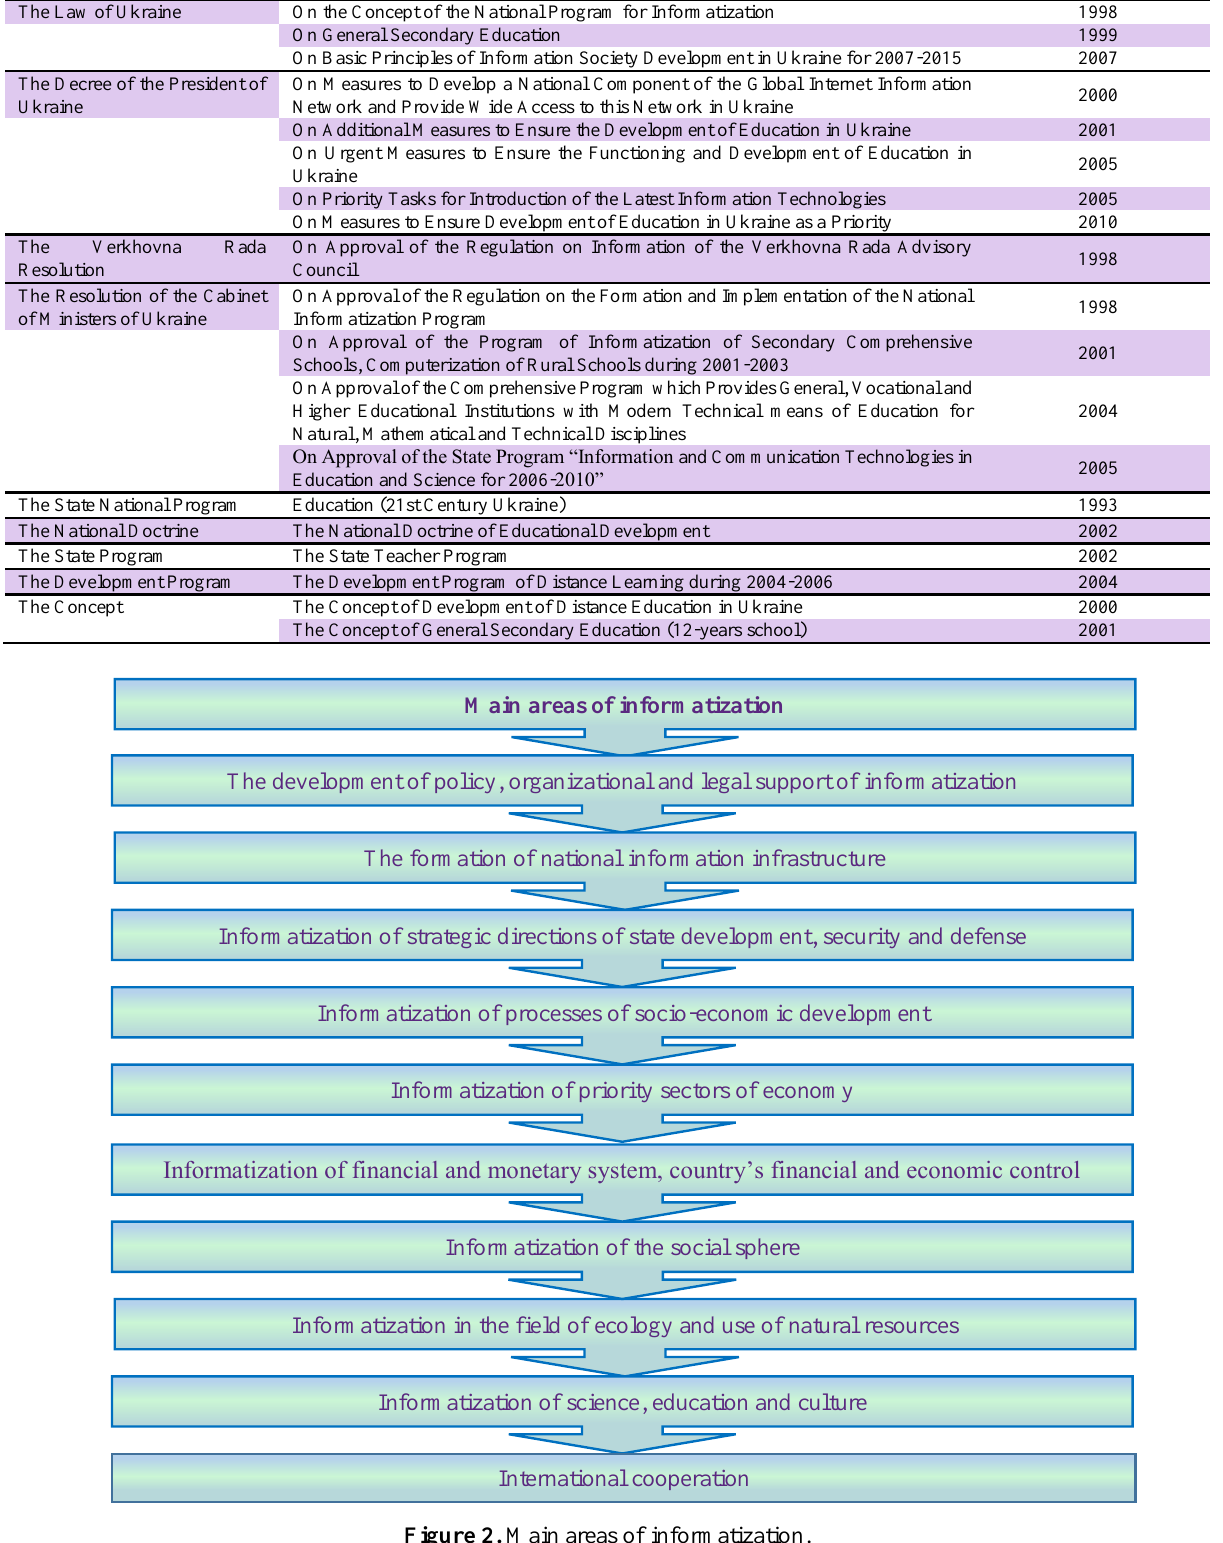
Figure 2. Main areas of